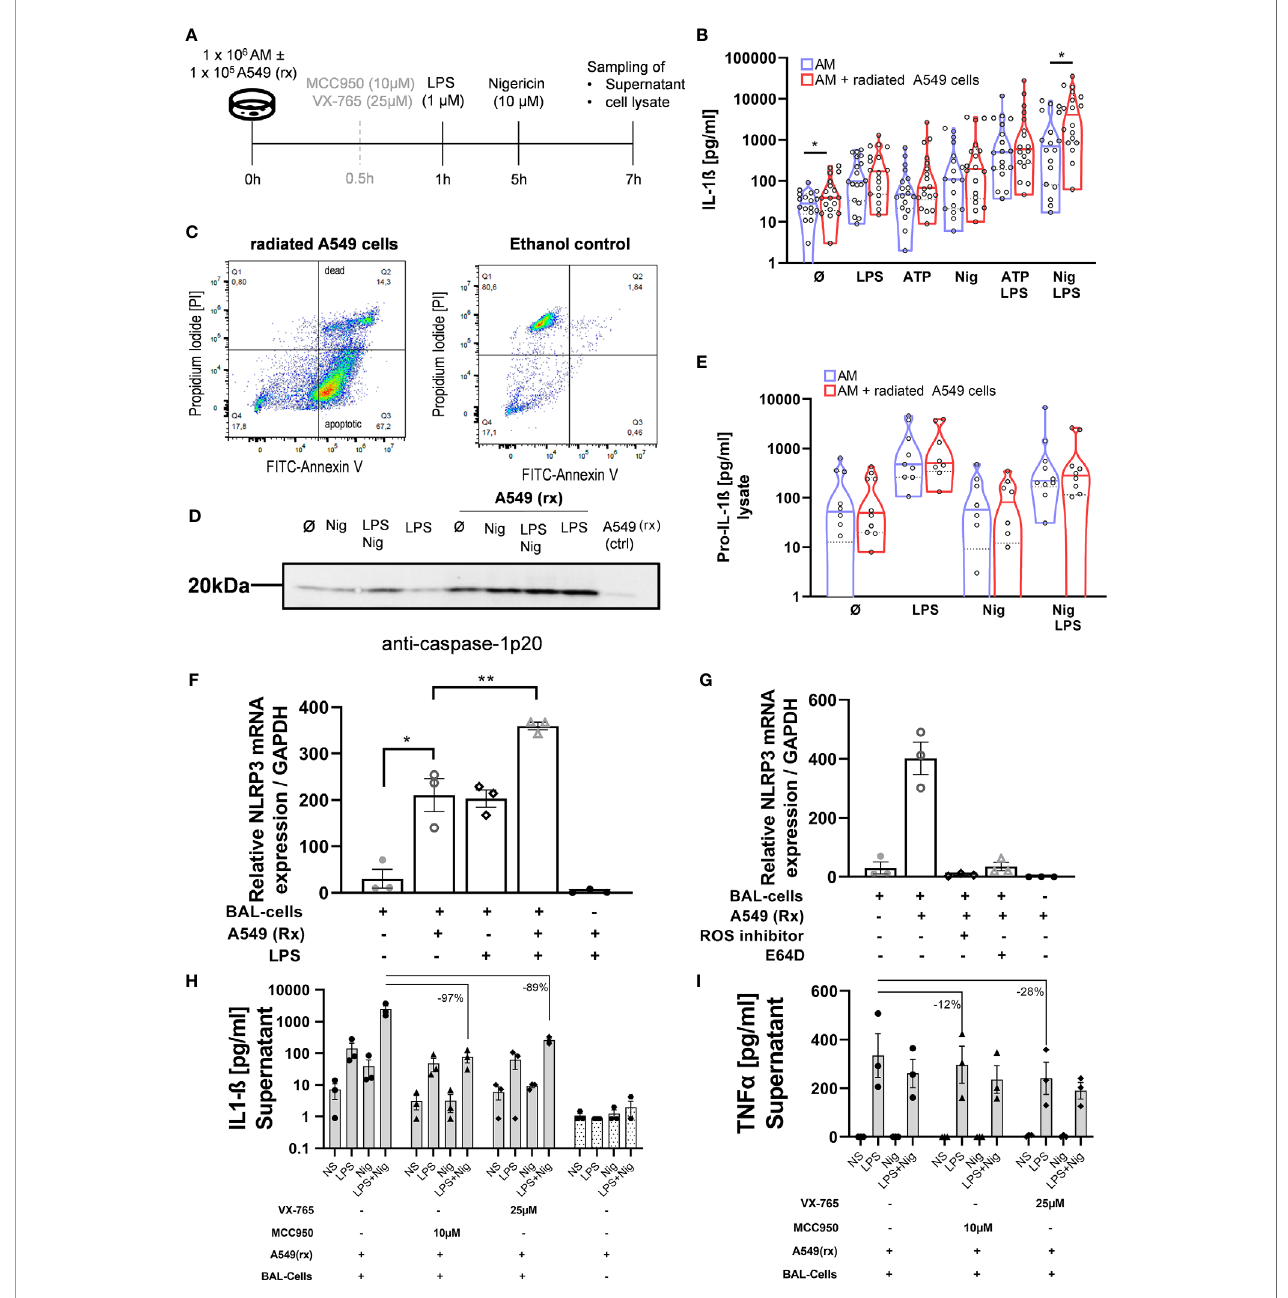
FIGURE 3 | Efferocytosis of apoptotic alveolar epithelial cells activates the NLRP3 in fl ammasome in AM. BAL cells were co-cultured with the radiated (rx) A549 cells, and the NLRP3 in fl ammasome was additionally stimulated (A) . A549 cells were radiated with 10 Gy and incubated for 72h, following which the majority of the cells were apoptotic demonstrated by Annexin-V staining (C) . There were increased IL-1ß levels with all stimulations, which were statistically signi fi cant at baseline and following LPS + Nigericin (Nig) stimulation (B) . Increased caspase-1 activation with A549(rx) co-culture was demonstrated by immunoblotting of cleaved caspase- 1p20 subsegment (representative blot shown; total of n = 3 immunoblots performed) (D) . Pro-IL-1ß levels in cell lysate were not different between BAL cells and BAL cells co-cultured with A549(rx) cells (E) . NLRP3 mRNA expression was assessed after 2h of stimulation, w/wo the presence of A549(rx). BAL cells cocultured with A459(rx) expressed NLRP3-mRNA in a similar range as BAL cells stimulated with LPS alone (F) . Combined stimulation of LPS and A549(rx) resulted in a marked increase in NLRP3-mRNA expression. The effect on NRLP3-mRNA expression (relative to GAPDH) by efferocytosis was inhibited by either a NADPH-Oxidase inhibitor (ROS-inhibitor; DPI) or a cathepsin inhibitor (E64D) (G) . IL-1ß production could be inhibited by inhibition of NLRP3 (MCC950) and also caspase-1 (VX-765) (H) , while TNF- a levels were largely retained (I) . IL-1ß levels and NLRP3 mRNA levels were compared using unpaired t-tests; *p < 0.05; **p < 0.01; N.S. non-signi fi